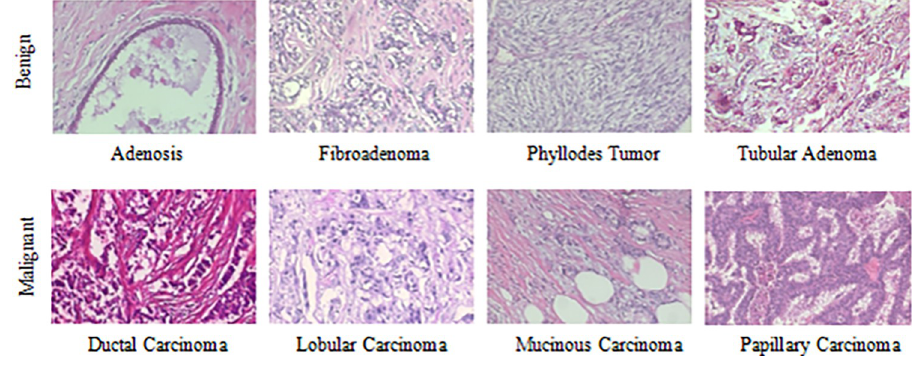
Fig 2. Representative examples with magnification of 100 × of BreaKHis